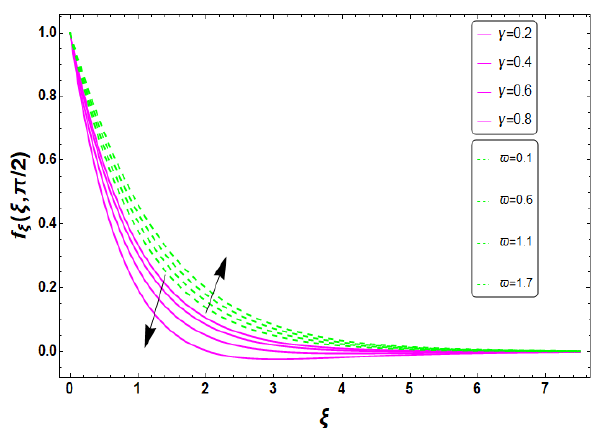
ϖ γ and . Π and N .